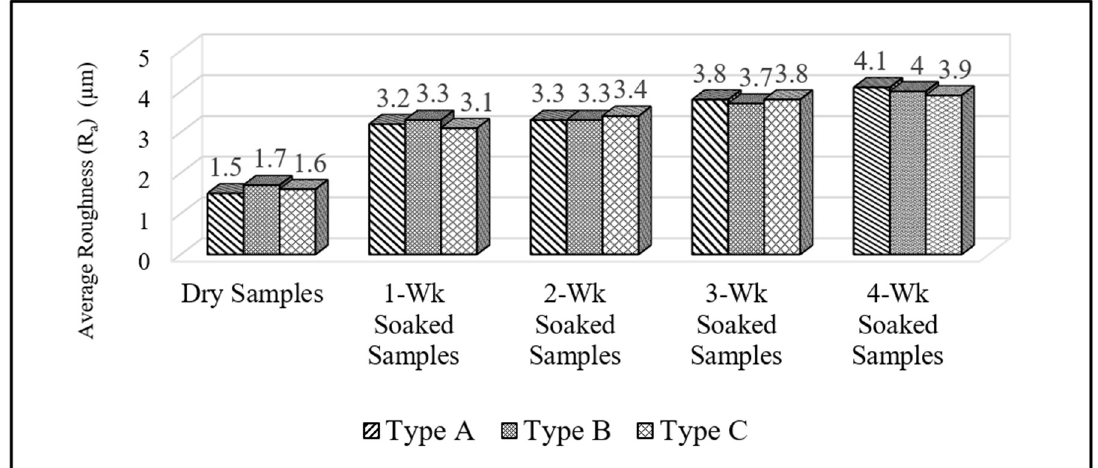
Figure 3. Average roughness (R a ) values of samples for di ff erent exposure times.